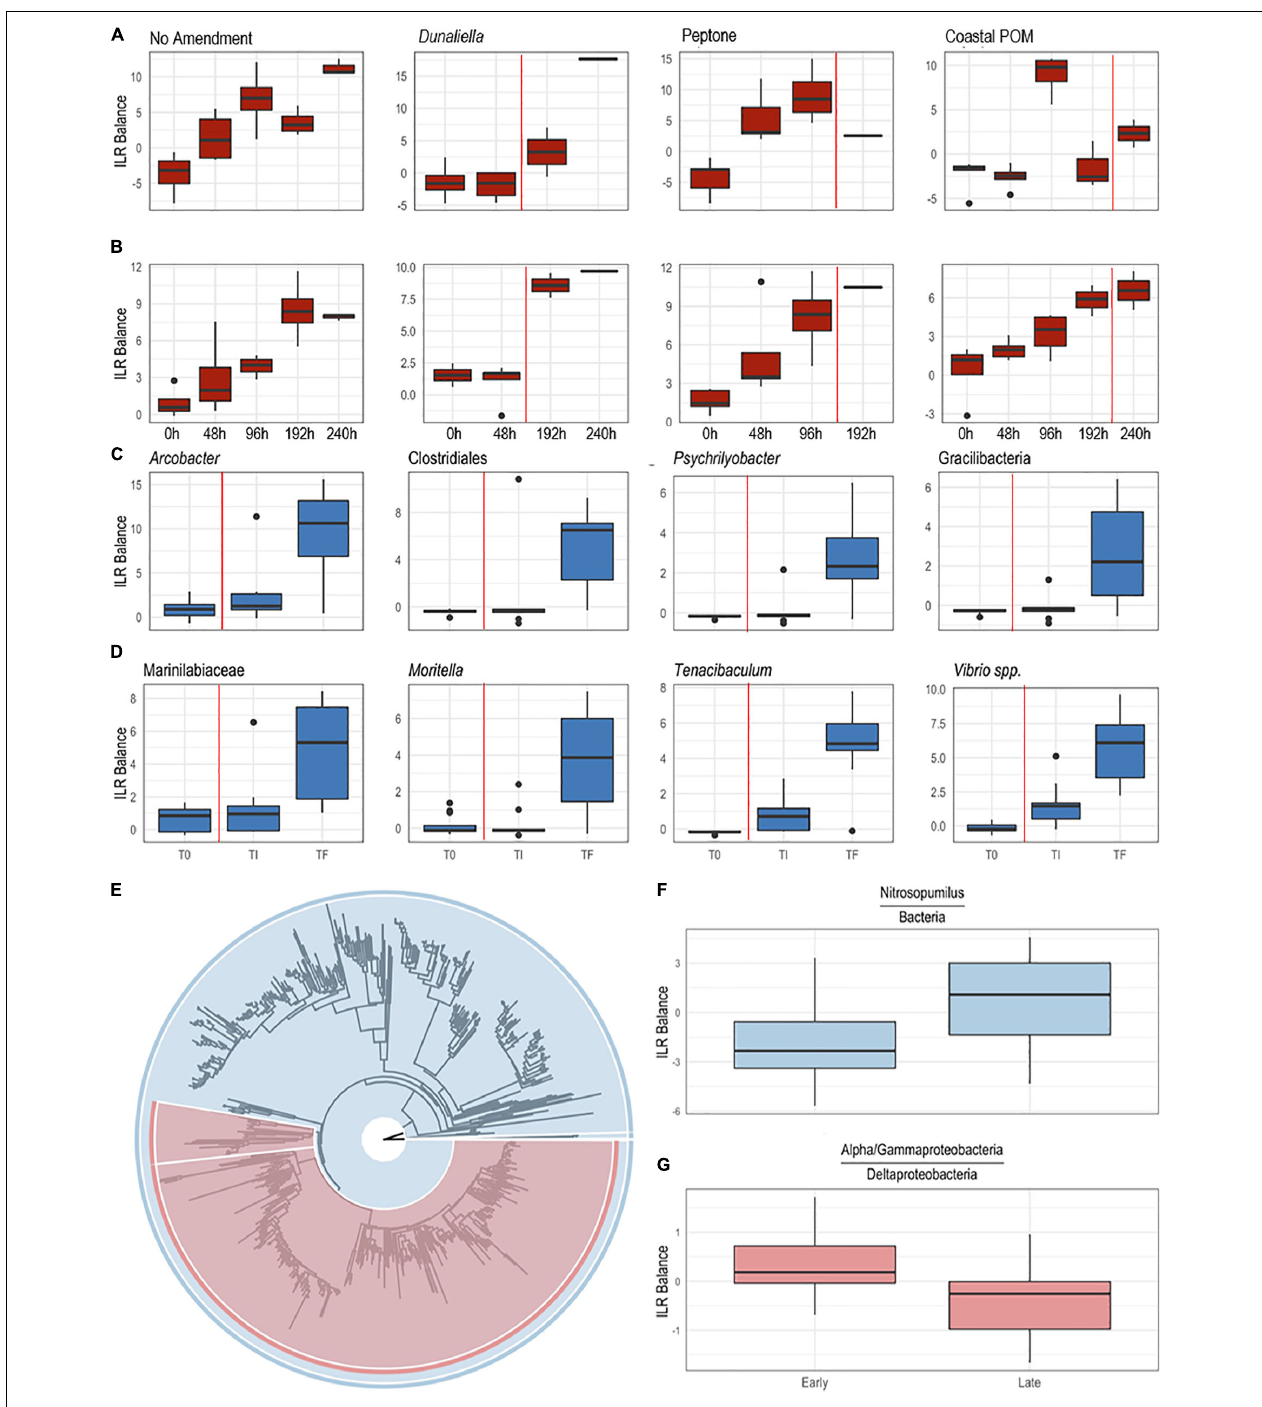
FIGURE 5 | Differential abundance of bacterial taxa from surface swabs [ (A,B,E–G) ; P. ochraceus August 2019]; and body wall samples [ (C,D) ; P. ochraceus June 2018]. (A,B) were derived from a PhyloFactor object and show the ILR balance of Flavobacteriales (A) and Rhodobacterales (B) relative to all other sOTUs. Organic amendment is given above boxplots. Total sample numbers for each treatment (which varied due to the loss of asteroids over the course of the experiment to wasting) is given in Figure 4 . The vertical red line in panels (A–D) indicate the average time at which asteroids formed lesions. (C,D) Boxplots were derived using PhyloFactor (Washburne et al., 2017), which uses a generalized linear model to regress the isometric log-ratio (ILR balance) between opposing clades (contrasted by an edge) on a phylogenetic tree. This was done iteratively, with each iteration, or factor, maximizing the F statistic from regression. Shown taxa represent either a single factor or combination of factors (when, for example, multiple factors identified different sOTUs with the same taxonomic classification). Labels represent either